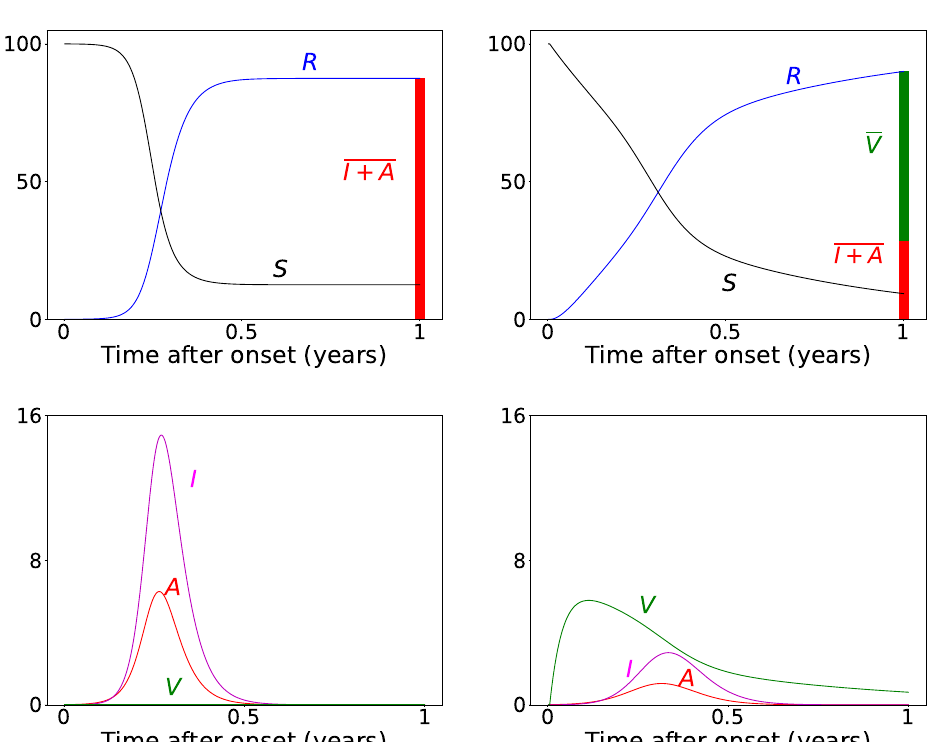
Figure 2. Time evolution of an outbreak obtained by numerically solving the SAIVR model, assum- ing persistent immunity ( κ = 0), acquired either by vaccination or infection recovery. The y-axis represents percentages (of the entire population, n). The x-axis represents time after the onset of the epidemic, the entire duration ( T ) of which is 1 year. Top row: Results without vaccine rollout (left panel) and with vaccine rollout (right panel) for the recovered population (blue curve) and the susceptible population (black curve). The red bar depicts the total number of infected individuals, I + A , calculated by Equation (3); the green bar depicts the total number of effectively vaccinated individuals, V , calculated by Equation (4). Bottom row: Symptomatic infected ( I , magenta curve), asymptomatic infected ( A , red curve), and vaccinated ( V , green curve) populations, without vaccine rollout (left panel) and with vaccine rollout commencing one day after the onset of the epidemic. For both cases, β 1 = 0.16, α 1 = 0.20, γ = 1/12, β 2 = 0.001, α 2 = 0.01, I 0 = 10 − 4 N , and A 0 = 0.2 I 0 . For the vaccination case, ζ = 0.001, η = 0.0005, λ = 0.95, ε = 1/14, and δ =